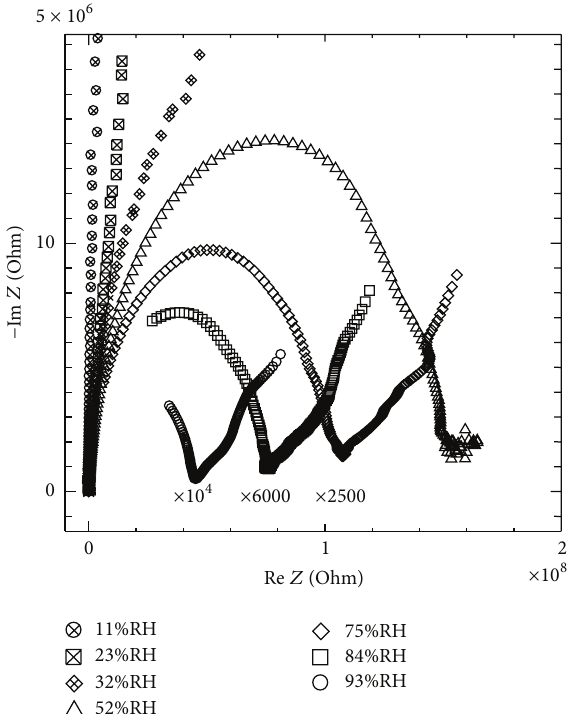
Figure 9: Complex impedance plot of Ag NPs humidity sensor at deposition time of 5min for different relative humidities at room temperature.